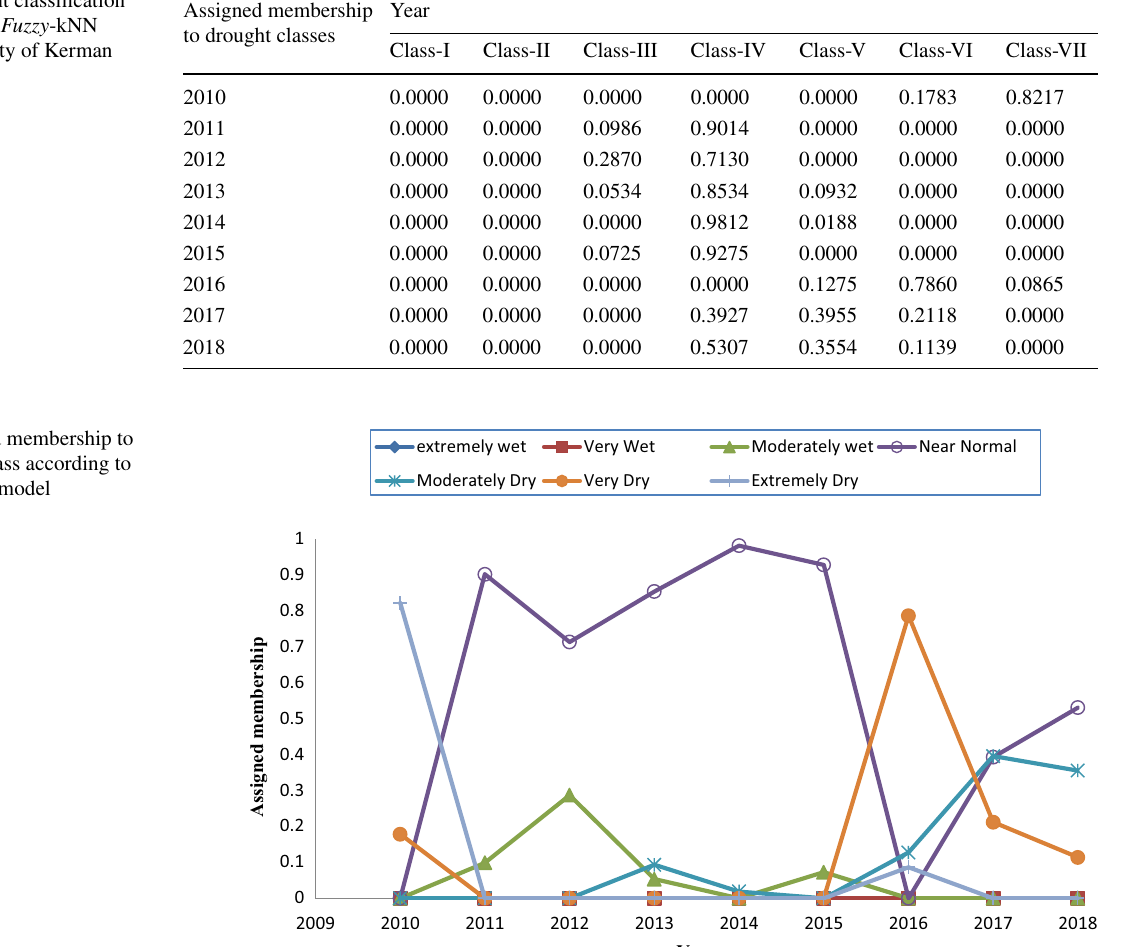
Assigned membership to drought classes